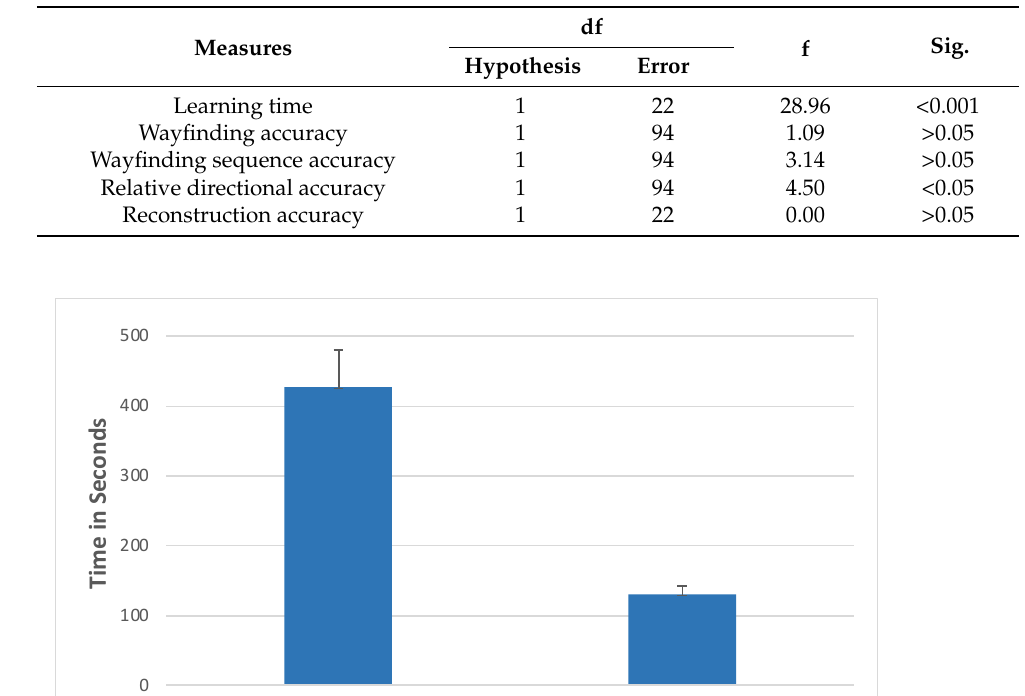
Table 4. ANOVA results for each of the tested measures comparing learning-mode conditions.